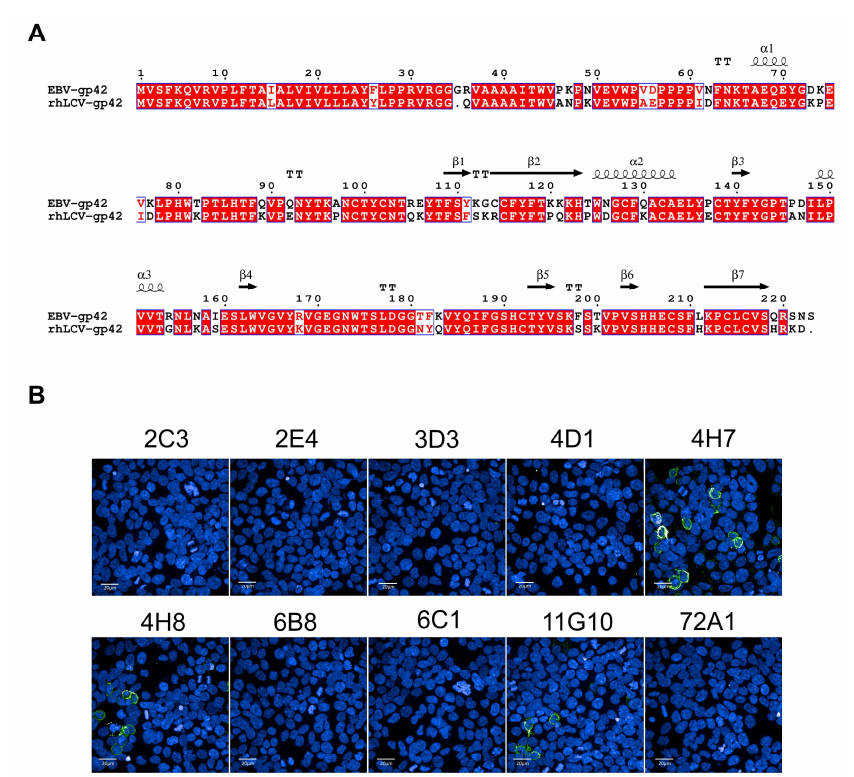
Figure 3. The cross-reactivity with rhLCV-gp42 of 9 mAbs. ( A ) Alignment of EBV (Genbank ID: KF373730.1) and rhLCV (Genbank ID: AY037858) gp42 using ESPript 3.0. The identical amino acids are marked in the red color. ( B ) Detection of the binding abilities of 9 mAbs with rhLCV-gp42 trans- fected 293β5 cells. The 72A1 was used as negative control.